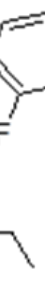
Figure 1. Structure of tested compound ZK-CH-11d.